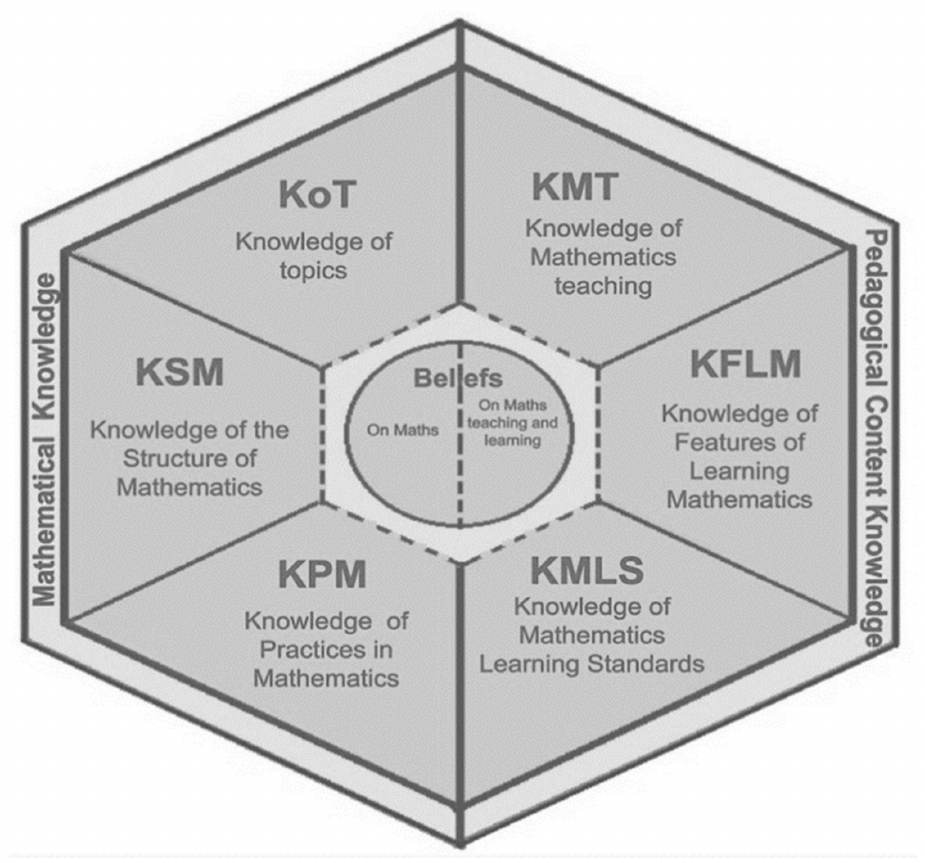
Figure 1. Domains and subdomains of the Mathematics Teacher’s Specialised Knowledge model [25]. Reproduced with permission from [25], Research in Mathematics